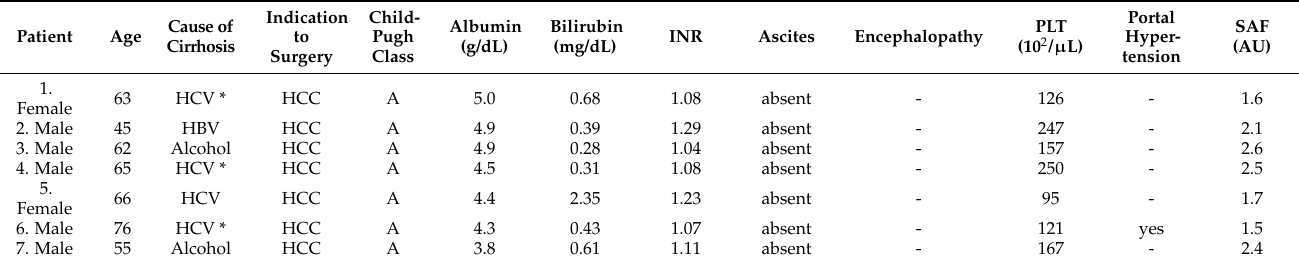
Table 2. Description of cirrhotic patients.